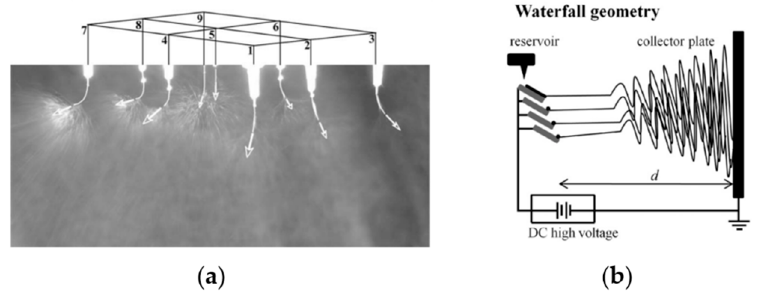
Figure 3. ( a ) Photograph of multi-jet electrospinning [99] (Copyright 2005, Elsevier); ( b ) schematic diagram of waterfall geometry electrospinning setup [100] (Copyright 2010, Elsevier).